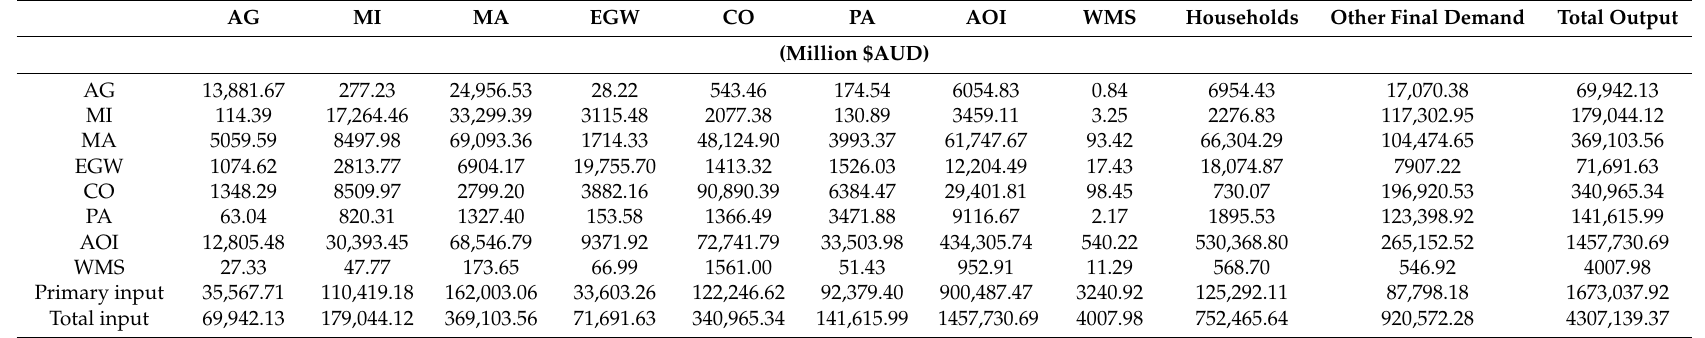
Table 4. The interpolation of Australian aggregation input-output table (IOT) of 2010–2011.